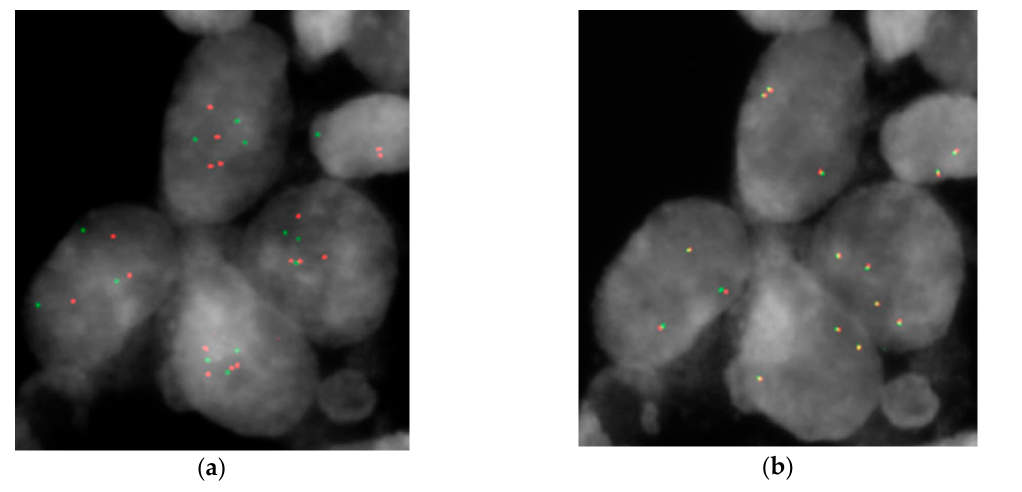
Figure 1. Examples of fluorescence in situ hybridization (FISH) analysis on formalin-fixed, paraffin-embedded (FFPE) tissues on the same tumoral area (case 27): ( a ) Her -2/ Neu (17q12)/SE17 (SE: satellite enumeration) probe (human epidermal growth factor receptor 2 ( HER2 ) red, centromere 17green); ( b ) PPAR γ Break probe. Yellow dots represent the fusion of green and red signals of the dual color split probe.